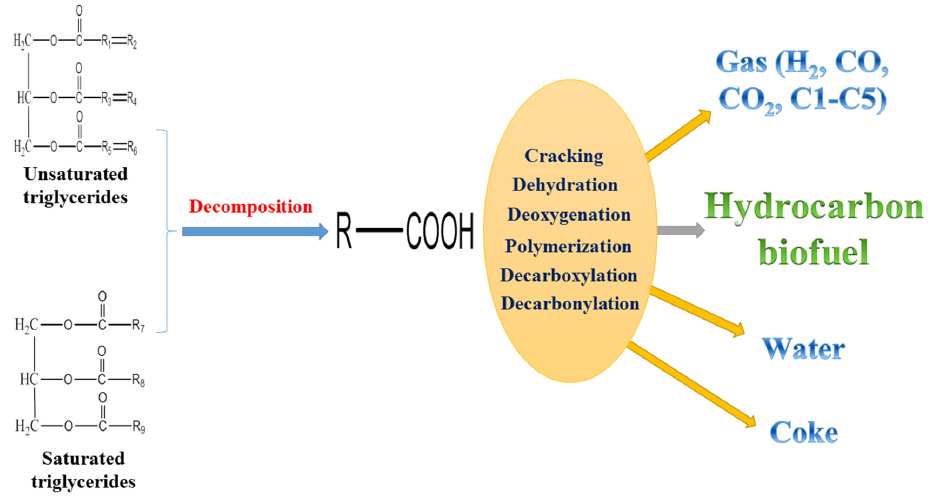
Figure 1. A proposed reaction pathway in the catalytic cracking of vegetable oil to hydrocarbon biofuel.